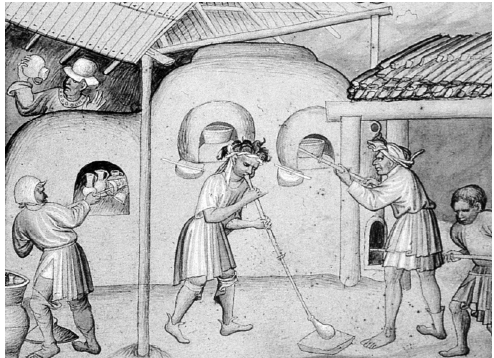
Figure 3: Annealing of glass as practiced in the left-hand side oven, the last step after completion of blowing of the gob of molten glass prepared in the two pots of the bigger oven (detail of a 15 th century miniature illustrating The Travels of Sir Mandeville